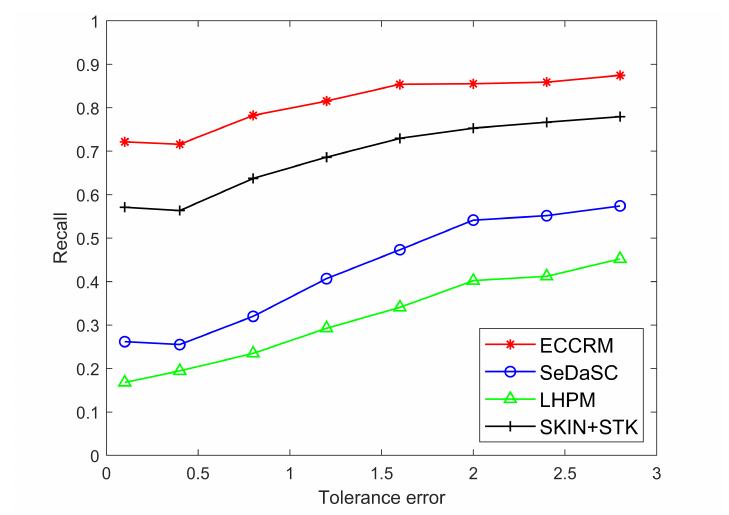
Figure 9. Comparison of recall of hot entities under different tolerance